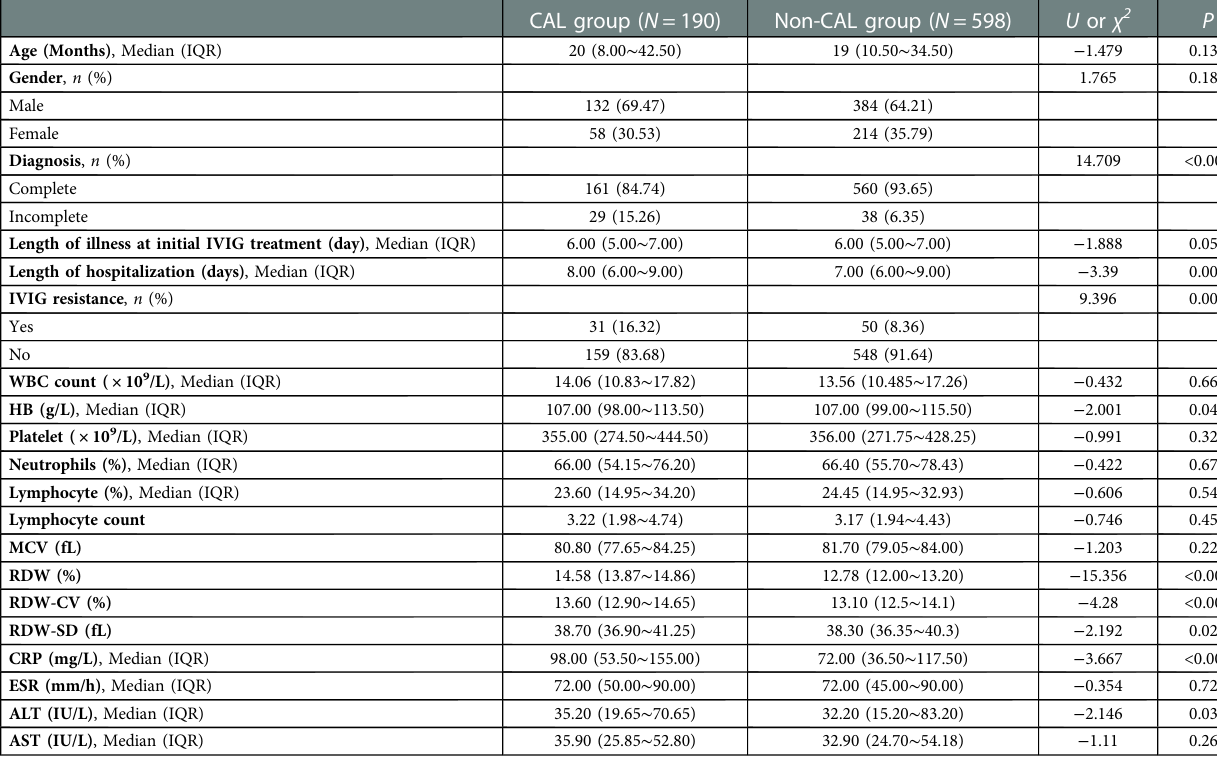
TABLE 1 Demographic and laboratory characteristics of patients with kawasaki